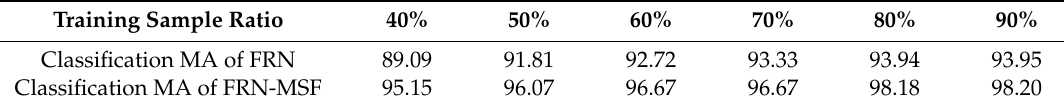
Table 6. Di ff erent training samples ratios and classification accuracies.